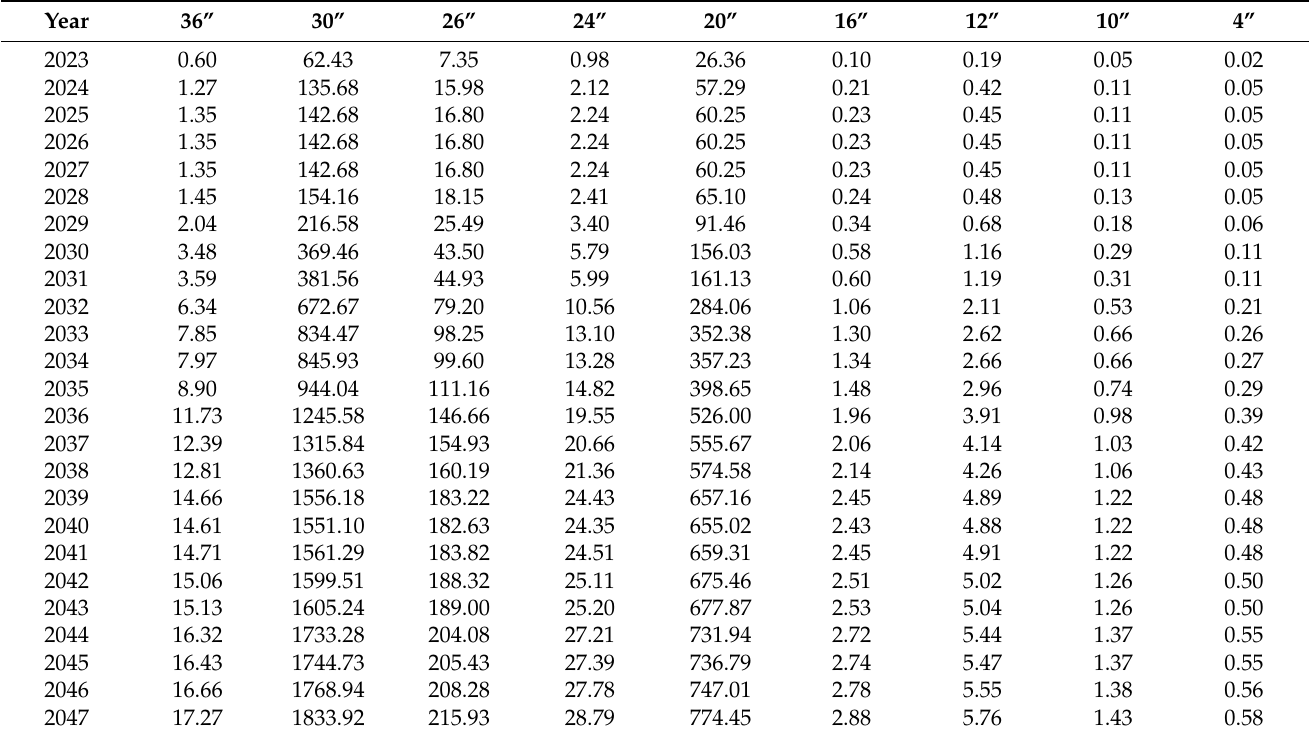
Table 8. Total hydrogen pipeline length for each diameter by